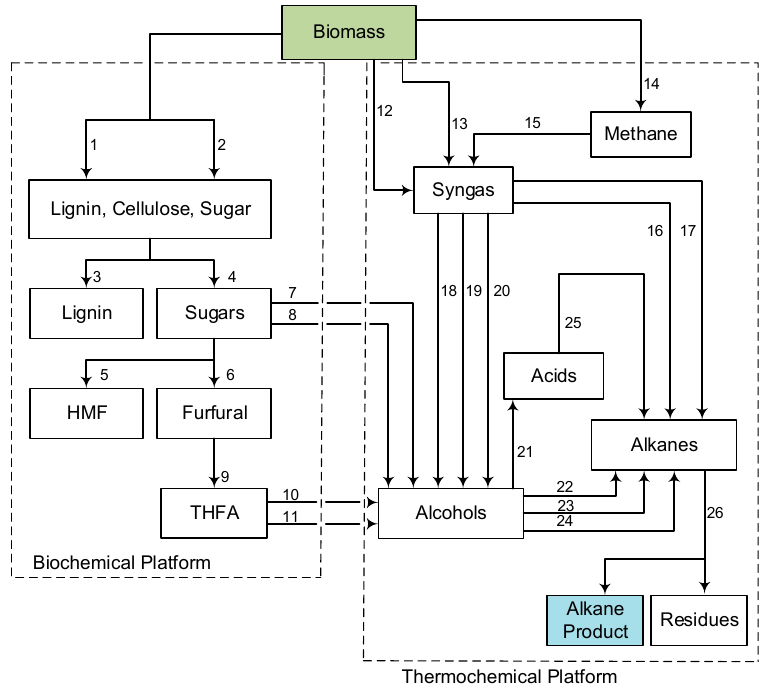
Figure 3. Conversion pathway of integrated biorefinery.